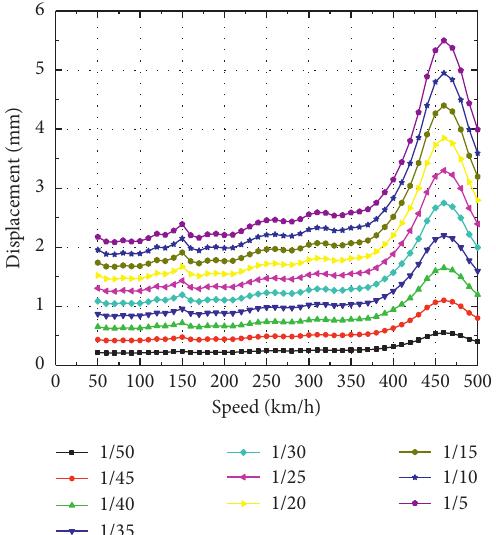
Figure 16: Dynamic coefficient deviation rate of the bridge under the spring-damping-mass model.